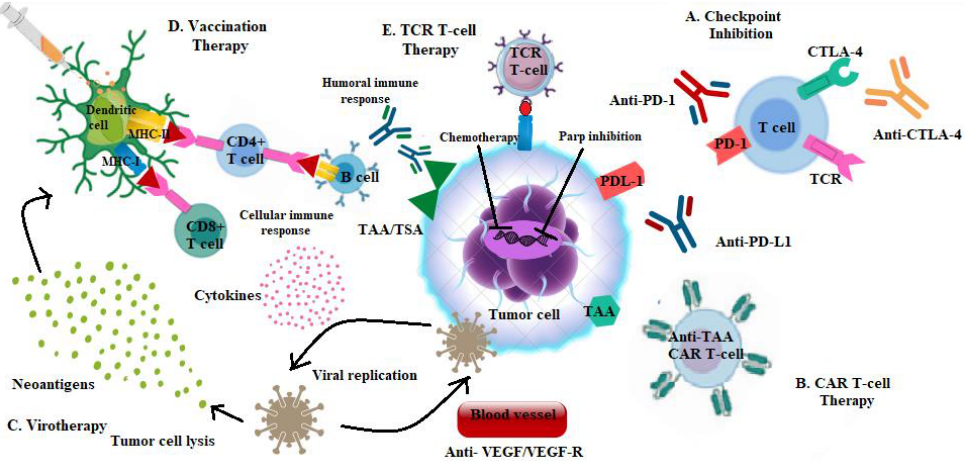
Figure 1. Immunotherapeutic strategies for the treatment of TNBC. Several studies are combining checkpoint blockades with multiple therapies, including traditional chemotherapy; PARP inhibitors; anti-VEGF/VEGF-R agents; anti-CTLA-4 antibodies or novel strategies including virotherapy, vacci- nation therapy, CAR T-cell or TCR T-cell therapy in order to overcome the mechanisms involved in the impairment of antitumor immune responses. Abbreviations: TCR: T-cell receptor; MHC-I: Major histocompatibility complex class I; MHC-II: Major histocompatibility complex class II; CTLA-4: Cyto- toxic T-Lymphocyte Antigen 4; PD-1: Programmed cell death protein 1; PD-L1: Programmed death ligand 1; CAR: Chimeric antigen receptor; TAA: Tumor-associated antigen; TSA: Tumor-specific anti- gen; TCR:T cell receptor; VEGF: vascular endothelial growth factor; VEGF-R-: vascular endothelial growth factor